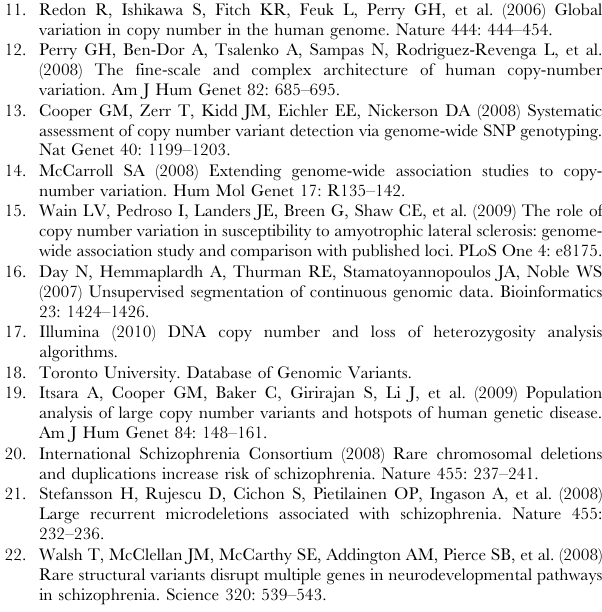
Figure S6 Process Flow Chart based on HMMSeg alone. Found at: doi:10.1371/journal.pone.0014456.s006 (2.80 MB TIF) Figure S7 Process Flow Chart based on cnvPartition (3-probe minimum) alone. Found at: doi:10.1371/journal.pone.0014456.s007 (2.80 MB TIF) Figure S8 Process Flow Chart based on PennCNV alone. Found at: doi:10.1371/journal.pone.0014456.s008 (2.80 MB TIF) Figure S9 Process Flow Chart based on QuantiSNP alone. Found at: doi:10.1371/journal.pone.0014456.s009 (2.80 MB TIF) Figure S10 Process Flow Chart based on overlap between HMMSeg, cnvPartition (3-probe minimum), PennCNV, and QuantiSNP. Found at: doi:10.1371/journal.pone.0014456.s010 (2.80 MB TIF) File S1 Datasets S1–S10. Coordinates of CNVs not previously published in databases of normal subjects. Found at: doi:10.1371/journal.pone.0014456.s011 (0.24 MB